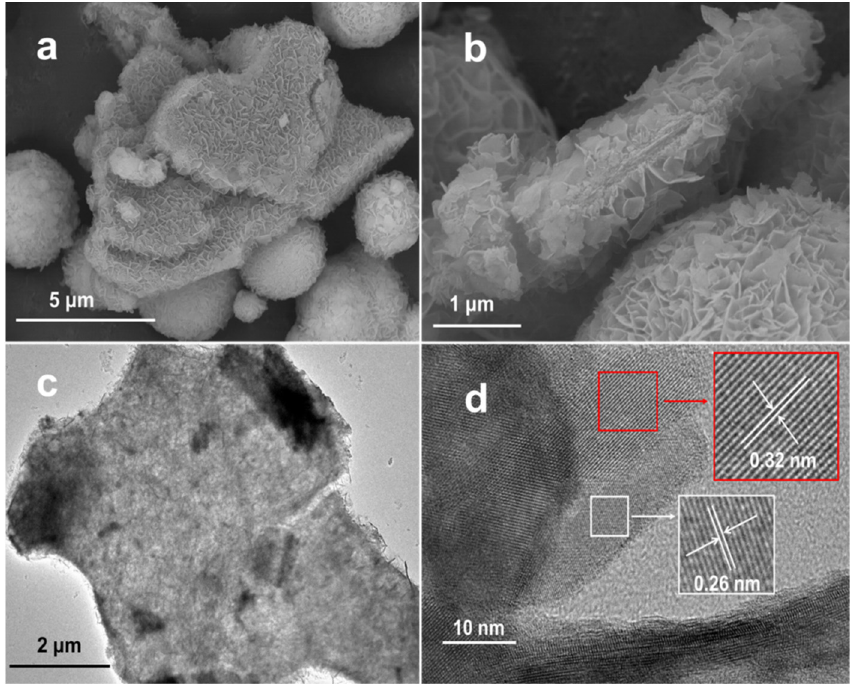
Figure 5. SEM images ( a , b ), ( c ) TEM, and ( d ) HRTEM images of ZnIn 2 S 4 /Ti 3 C 2 composites (ZIST-5).